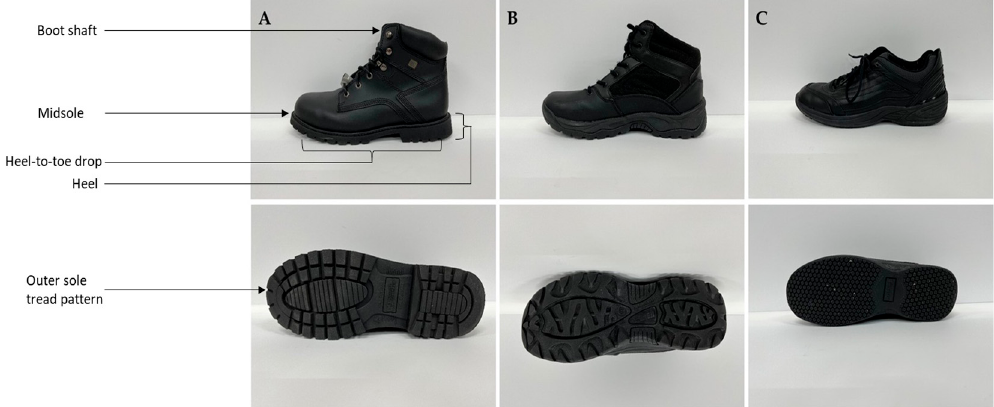
Figure 1. ( A ) Steel-toed work boot (SB), ( B ) tactical work boot (TB), ( C ) low-top slip resistant work boot (SR). Table 1. Occupational footwear design features.